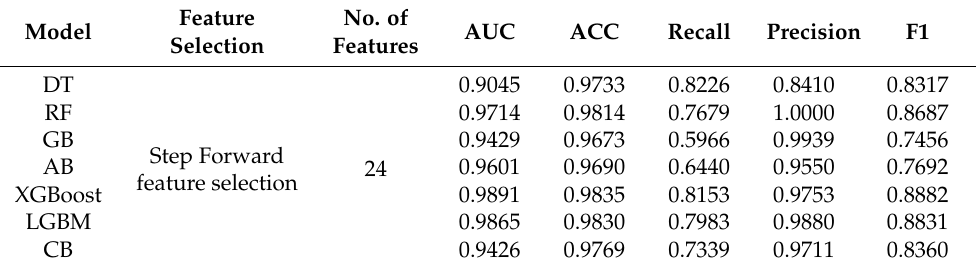
Table 7. Experiment II: Testing results of the proposed classifiers after applying step forward feature